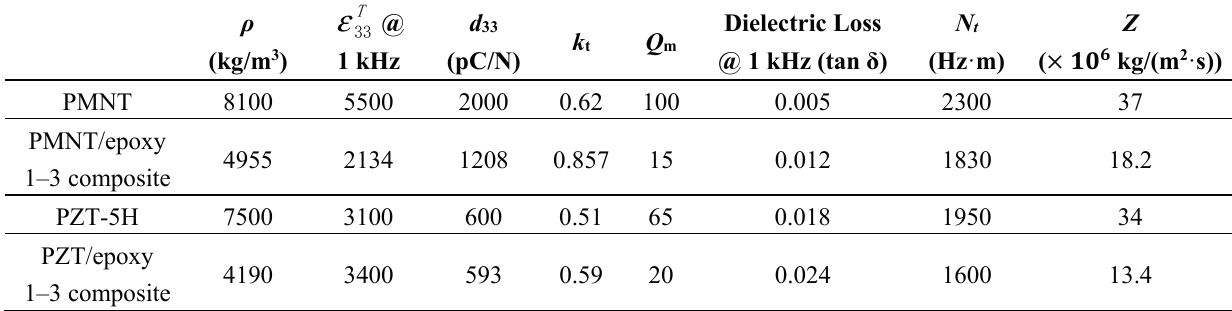
Figure 2. The impedance and phase angle spectra of the prepared PMNT/epoxy 1–3 composite. Table 1. The properties of the prepared PMNT/epoxy 1–3 composite and some other common piezoelectric